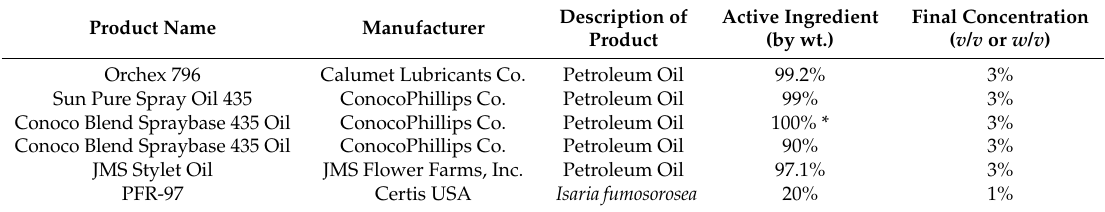
Table 1. Details of the emulsifier and entomopathogen used in different